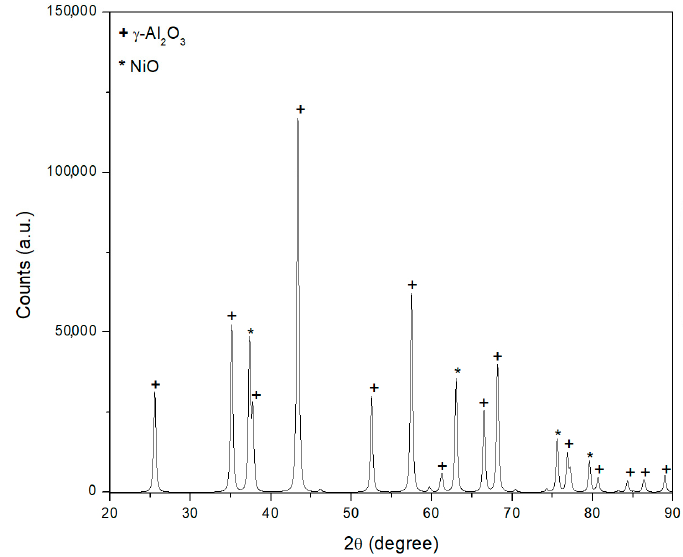
Figure 1. XRD diffractogram of synthesized Ni/Al 2 O 3 catalyst.